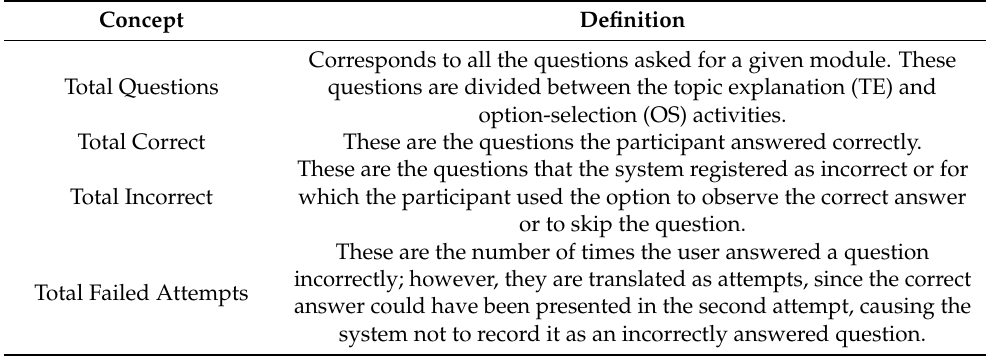
Table 3. Concepts of the question results.